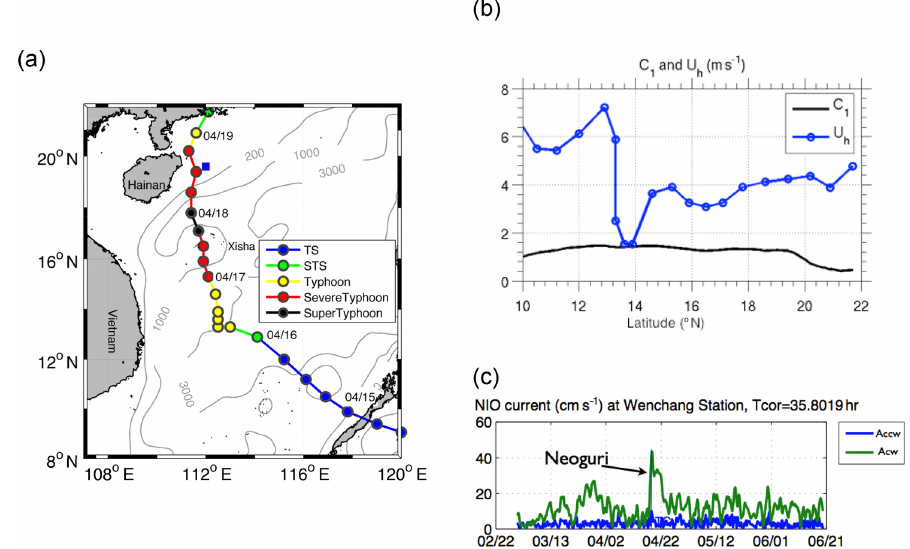
Figure 1. (a) Track of Typhoon Neoguri (2008) from JTWC; blue square represents Wenchang where there were ADCP observations; (b) translation speed ( U h ; unit: ms − 1 ) and the first baroclinic wave speed ( C 1 ; unit: ms − 1 ) along the TC track; (c) clockwise ( A cw ) and counter-clockwise ( A ccw ) rotary current amplitude (ms − 1 ) from current measurement at Wenchang. TS: tropical storm; STS: strong tropical